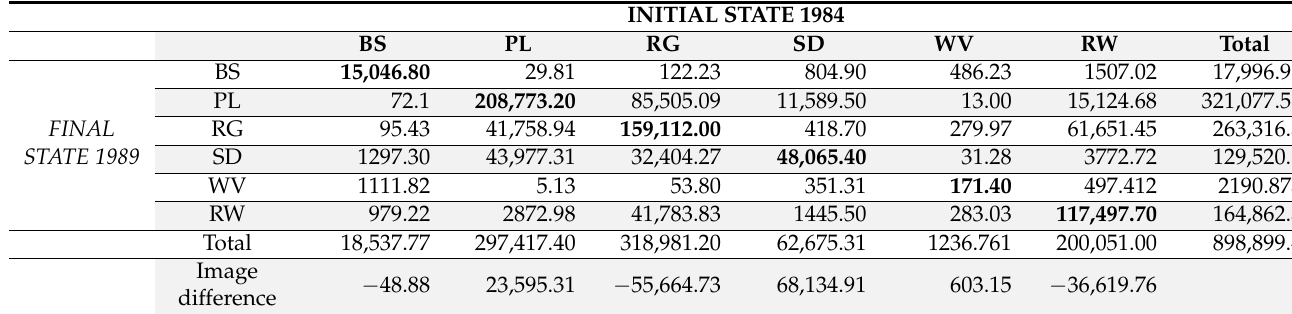
Table 4. Change matrix of the rainfed agriculture and other LULC types in hectares of North Darfur State from 1984 to 1989. The bold values in the change matrix indicate unchanged land types between the initial and final years.